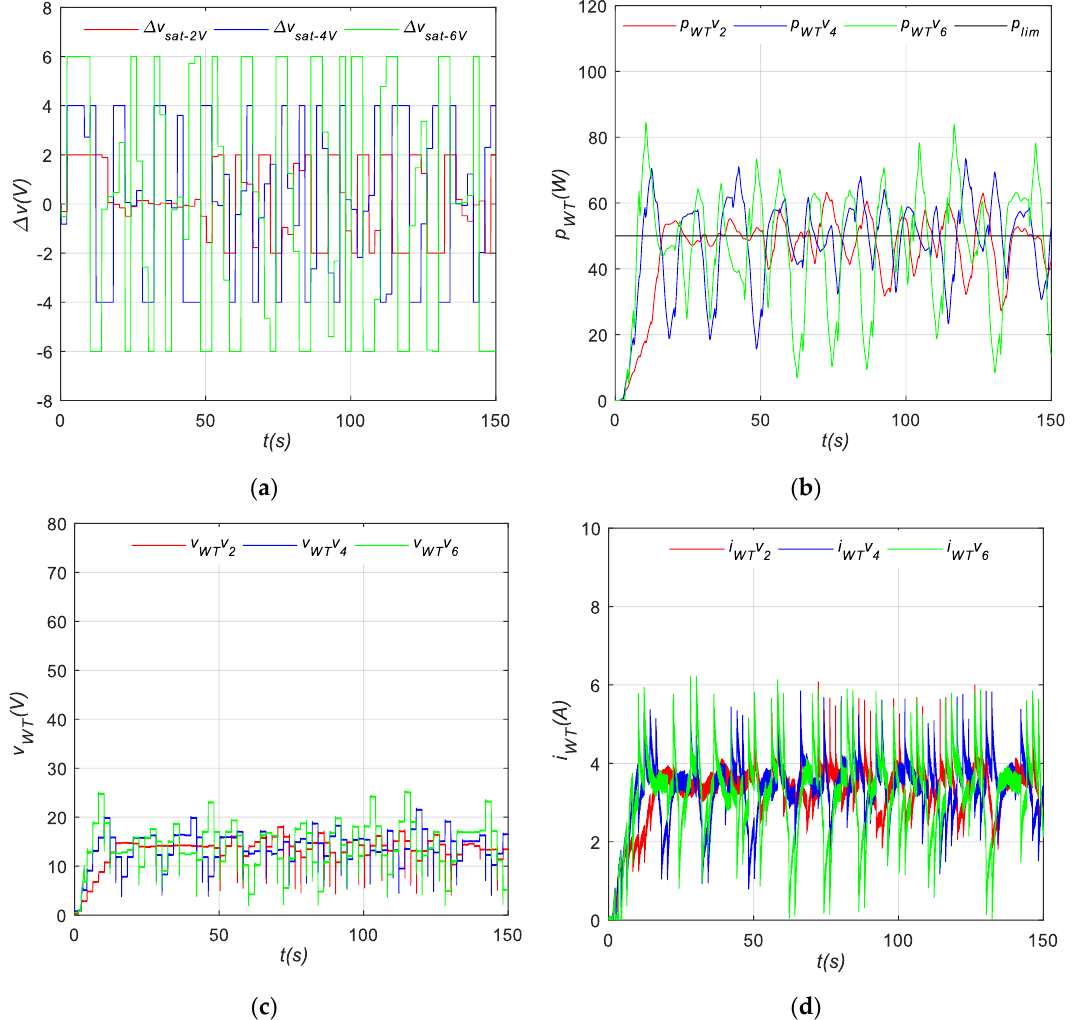
Figure 11. Newton’s variable step-size P&O for LPP1: ( a ) evolution of ∆ v ; ( b ) evolution of p ( c ) evolution of v WT ; ( d ) evolution of i WT .